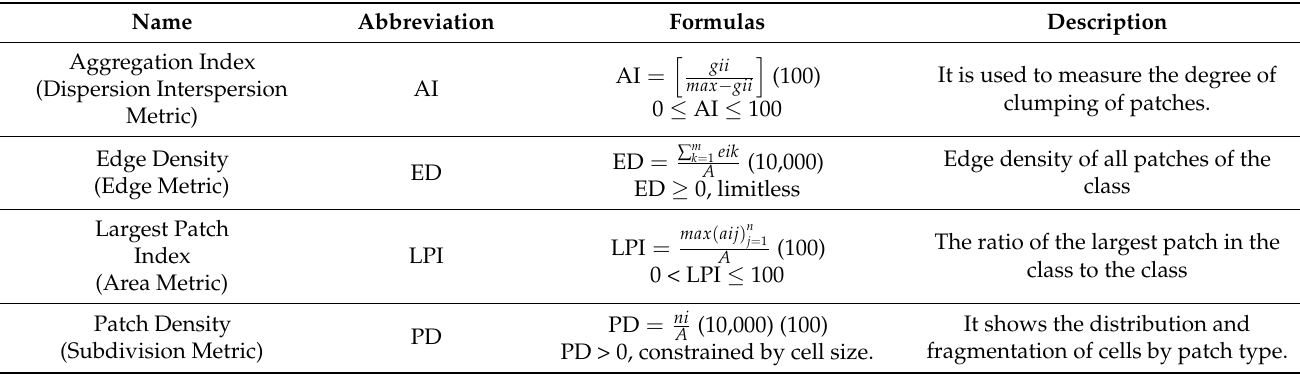
Table 3. Detailed information about the landscape indices implemented in FRAGSTATS 4.2.